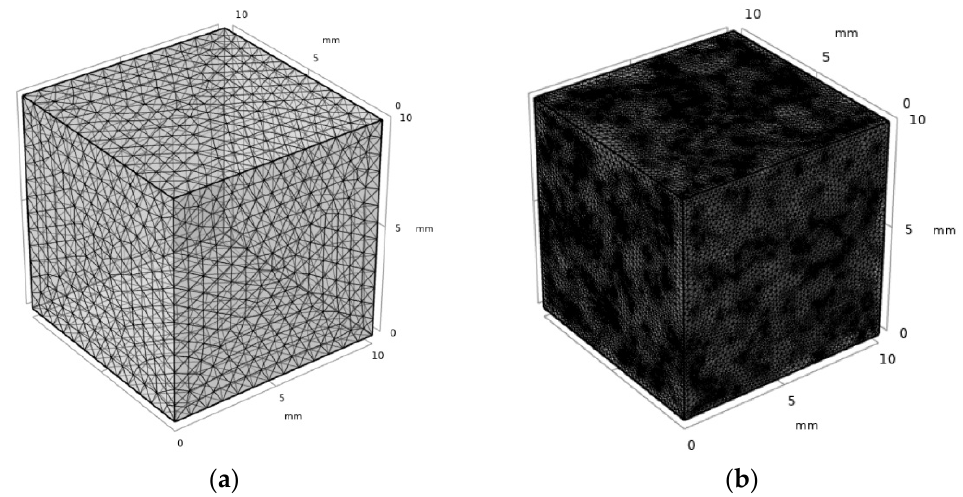
Figure 6. The meshing results of ( a ) reference concrete and ( b ) NAAC (curing temperature of 35 °C as an example).